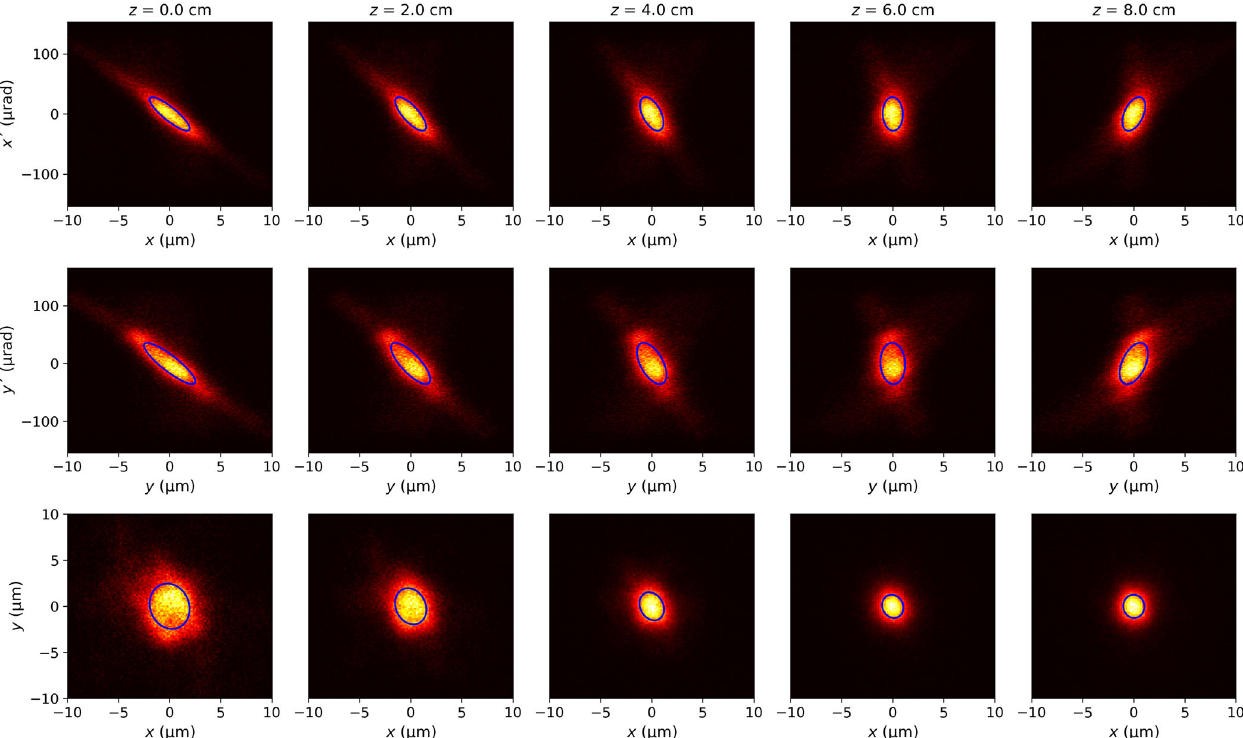
FIG. 6. 2D histograms of the phase space reconstructed from wire scan measurements. Subplots in the same column correspond to the same z location. The first row shows the x − x 0 and the second row shows the y − y 0 phase space. The last row depicts the corresponding beam profile ( x − y ). The 1 σ -ellipse of a 2D Gaussian fit is drawn in blue for each histogram.